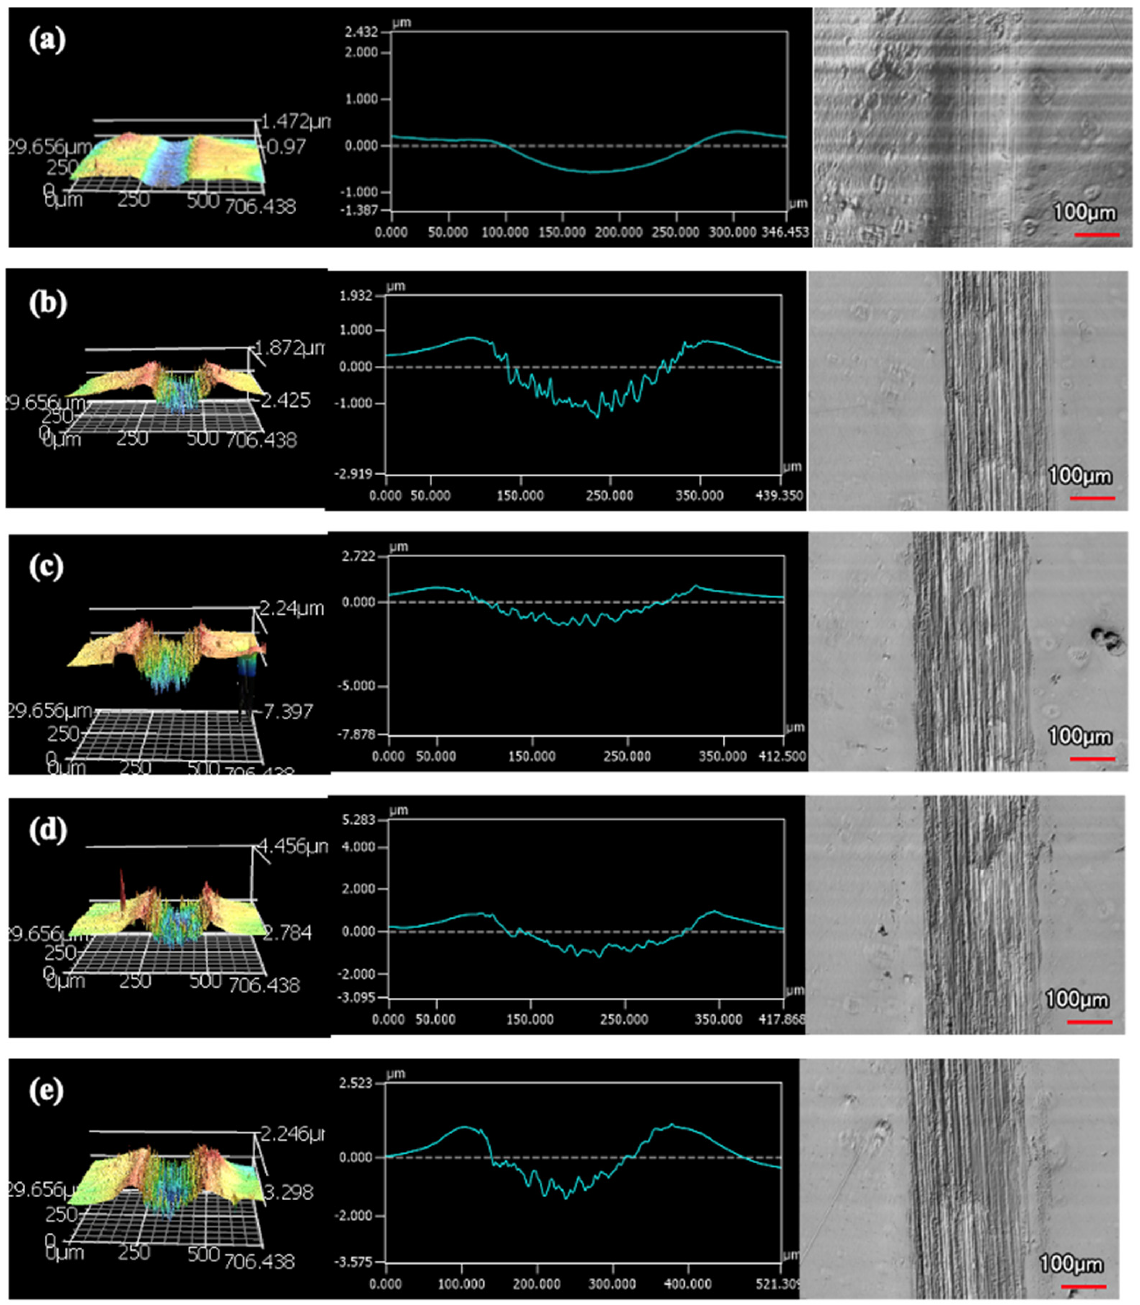
Figure 11. Wear Profiles from the Spherical Indenter on 9 μ m Thick Ni − P Coating: ( a ) 1 Pass, ( b ) 25 Passes, ( c ) 50 Passes, ( d ) 75 Passes, ( e ) 100 Passes.